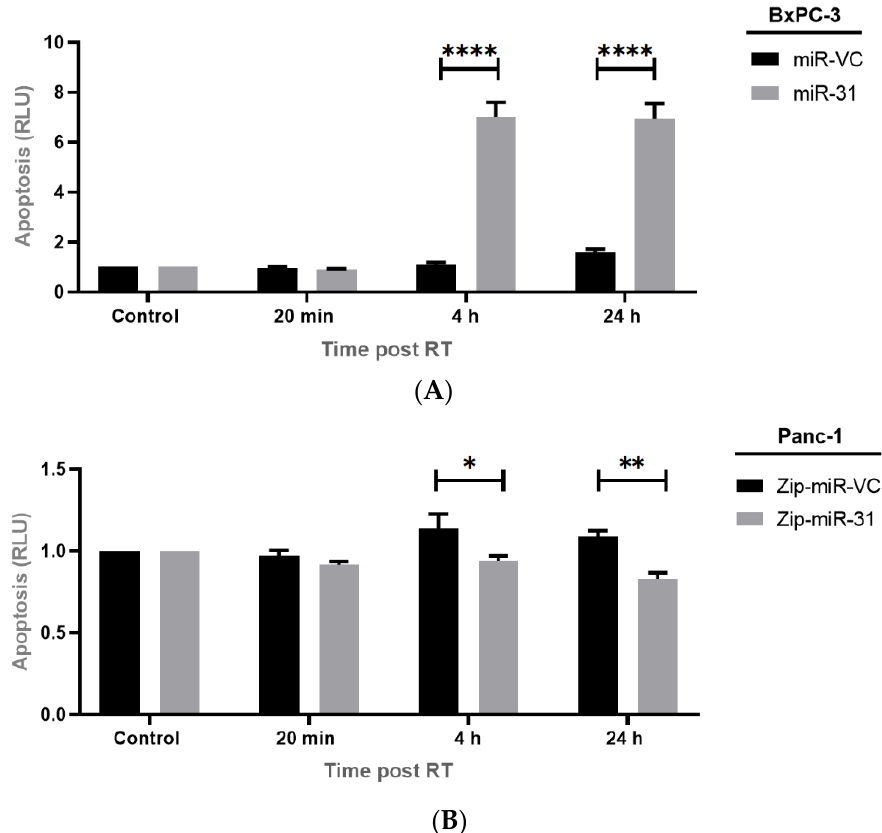
Figure 6. Manipulating miR-31 alters apoptosis in PDAC cells. Caspase 3/7 activity was measured as a marker of apoptosis at 20 min, 4 h, and 24 h post-radiation treatment (RT). ( A ) There were no significant differences in apoptosis in 20 min post-RT ( p > 0.999) between BxPC-3 miR-VC and BxPC-3 miR-31 cells. However, overexpressing miR-31 in BxPC-3 cells displayed a significant increase in apoptosis 4 h (**** p < 0.0001) and 24 h (**** p < 0.0001) post-RT. ( B ) There are no significant differences in apoptosis 20 min post-RT between Panc-1 Zip-miR-VC and Panc-1 Zip-miR-31 cells ( p = 0.9368). Although suppressing miR-31 in Panc-1 cells displayed a significant decrease in apoptosis 4 h (* p = 0.0199) and 24 h (** p = 0.00630) post-RT. Data are represented as the mean ± SEM ( n = 3). Two-way ANOVA with Tukey’s post-hoc test was adopted for statistical